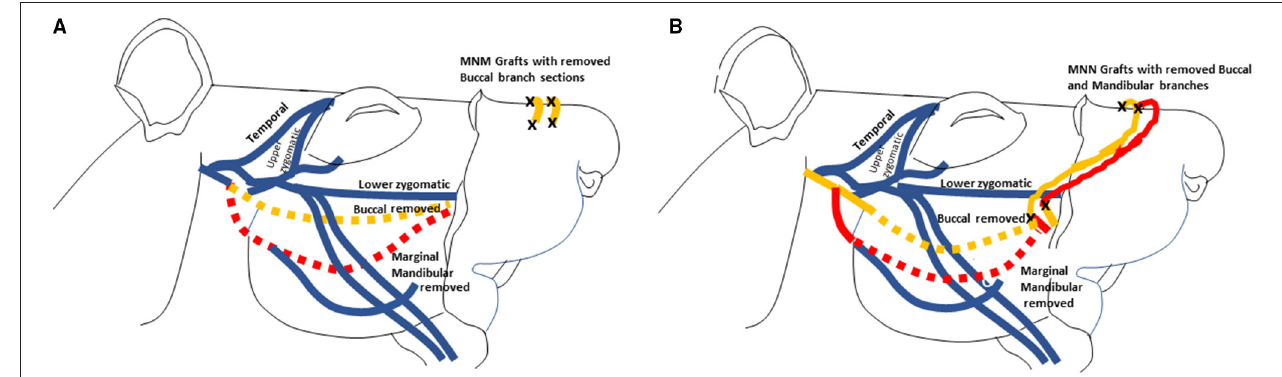
FIGURE 1 | Illustrations depicting of the MNM grafting technique with two grafts (A) , and the MNN (B) grafting technique are displayed. These images were adapted from drawings with permission from Braintree Scientific, Inc. (10). The buccal branch is displayed in orange and the marginal mandibular branch is in red. The dashed nerve lines represent when the nerves was removed. The black X demonstrates all the places where the nerve grafts were